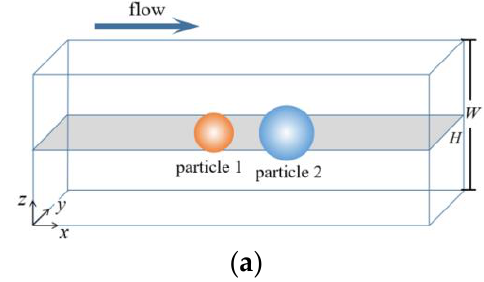
Figure 1. Two particles in Poiseuille flow of power-law fluid. ( a ) overall diagram, ( b ) on x - y plane.